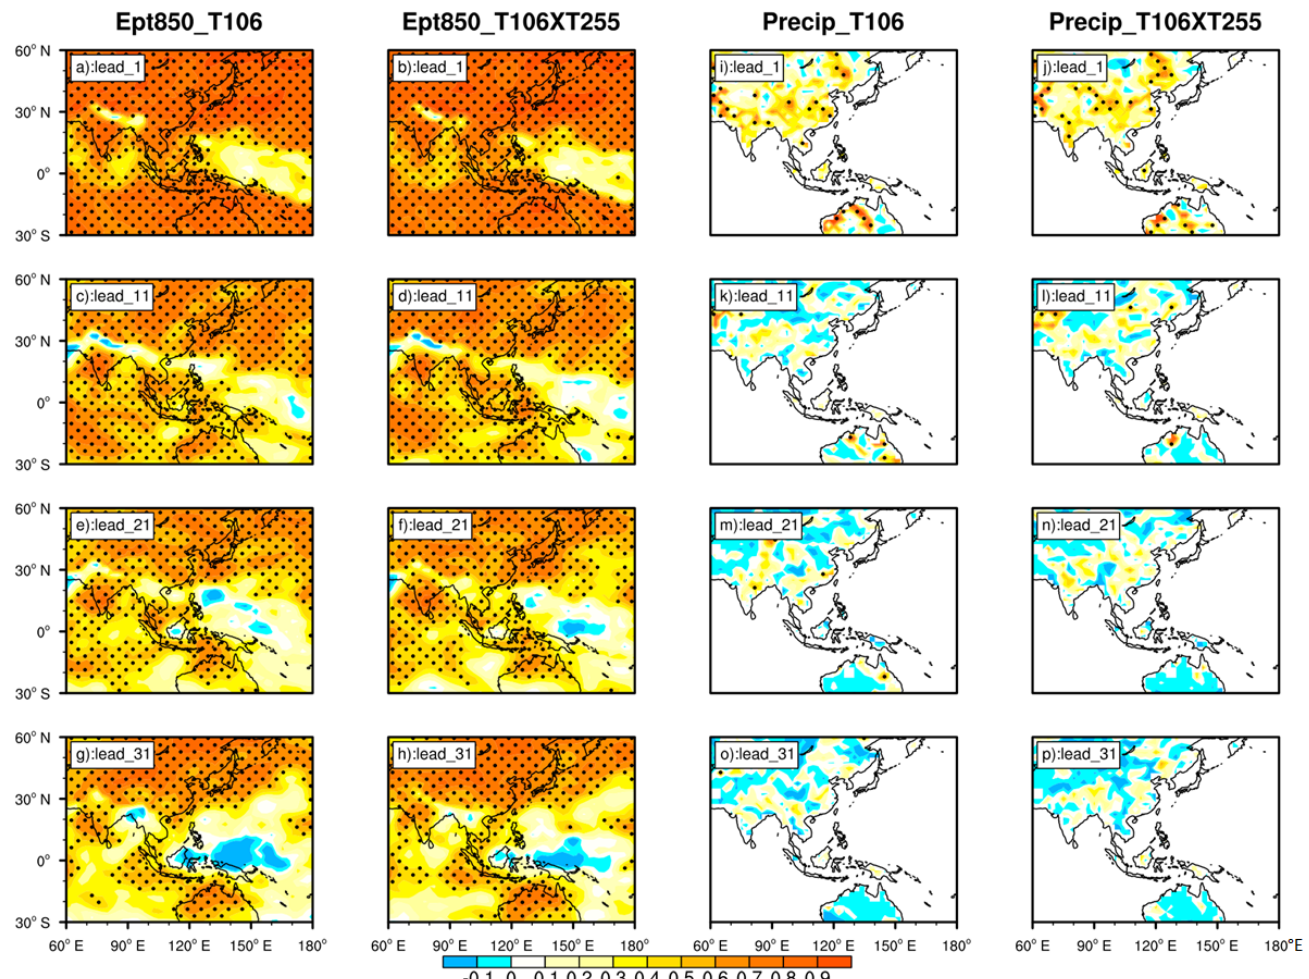
Figure 4. Same as Figure 2, but for 850 hPa θ se ( a – h ) and precipitation ( i – p ). In addition, the evolutions of the pattern correlation coefficient (PCC) of 850 hPa zonal and meridional winds before and after the SCSSM onset are analyzed. Zonal and meridional winds of 850 hPa in the region (20 ◦ S–30 ◦ N, 60 ◦ –150 ◦ E) are selected for our study (Figure 5). The PCC prediction for zonal wind is significantly higher than those for meridional wind. With the increasing lead times, the model’s PCC prediction skill gradually decreases. Furthermore, the prediction skill is weak during the adjustment phase of the circulation in late spring and improves significantly after the monsoon onset. Prediction for meridional wind is worse than that for zonal wind, consistent with basic prediction ability for zonal and meridional winds. Finally, attention is paid to the effect of schemes on the predicting ability (Figure 5c,f); no significant difference exists between T106 and T106 ×